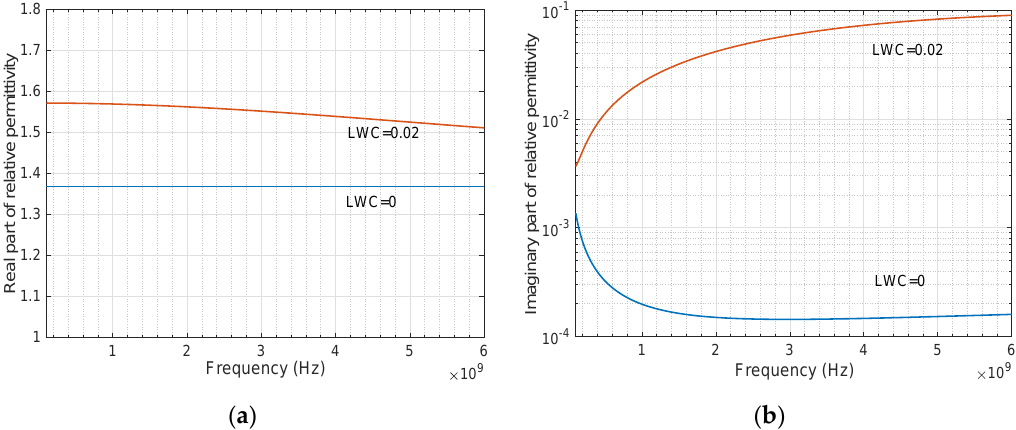
Figure 3. Relative dielectric permittivity of snow from 100 MHz to 6 GHz for dry snow and wet snow with a liquid water content (LWC) of 2% and a relative density of 0.2: ( a ) Real part of the relative permittivity. ( b ) Imaginary part of the relative permittivity.